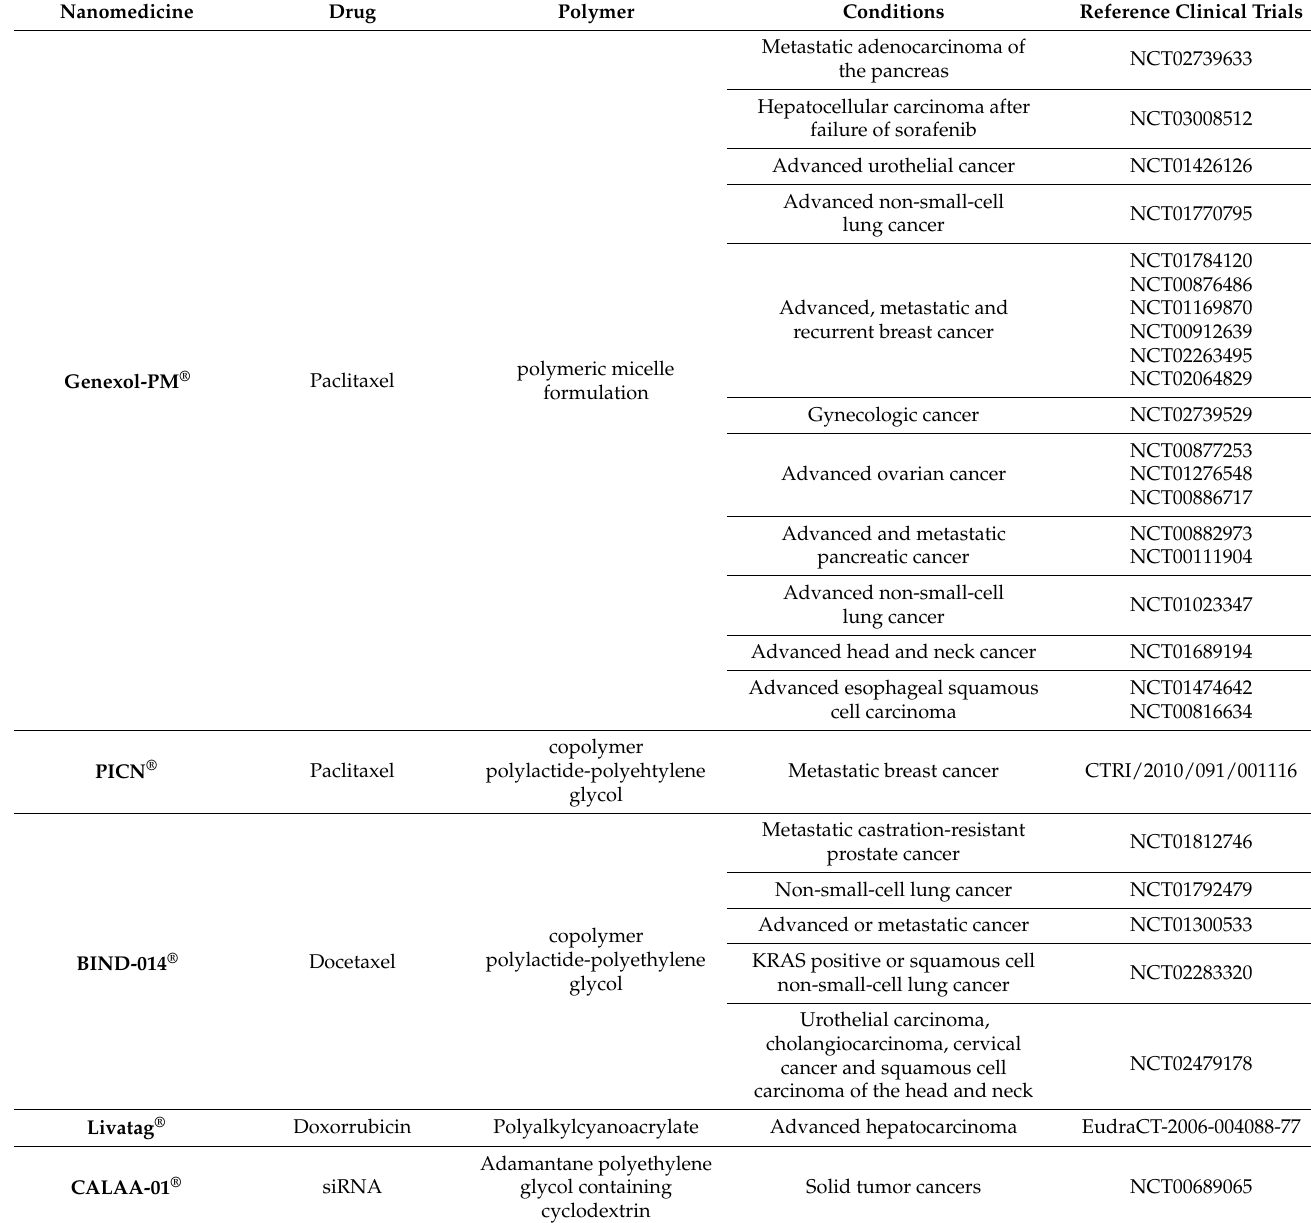
Table 3. Polymeric NPs in clinical